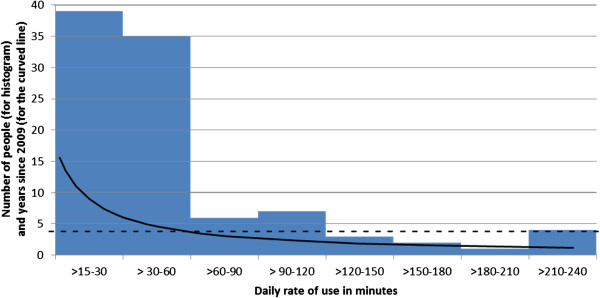
Short title: Time since survey to reach 1640 hours’ cordless phone use at the reported daily rate. Legend: This figure has a dual purpose. It shows both the reported time spent daily on a cordless phone (as a histogram) and the years since 2009 that it will take for participants to reach 1640 hours on a cordless phone at the reported rate of use (the black curved line). The curved line charts the critical rate of use over x years to reach 1640 hours’ use since the survey. The broken line indicates mid-2013 (4 years since the survey). All those to the right of where the lines cross (i.e. more than 60 mins/day) will have had ≥ 1640 hours’ exposure by mid-2013. This is equivalent to the top decile Interphone use. Previous use and cellphone use are not included. Only those who reported >15 minutes/day are shown in the histogram.